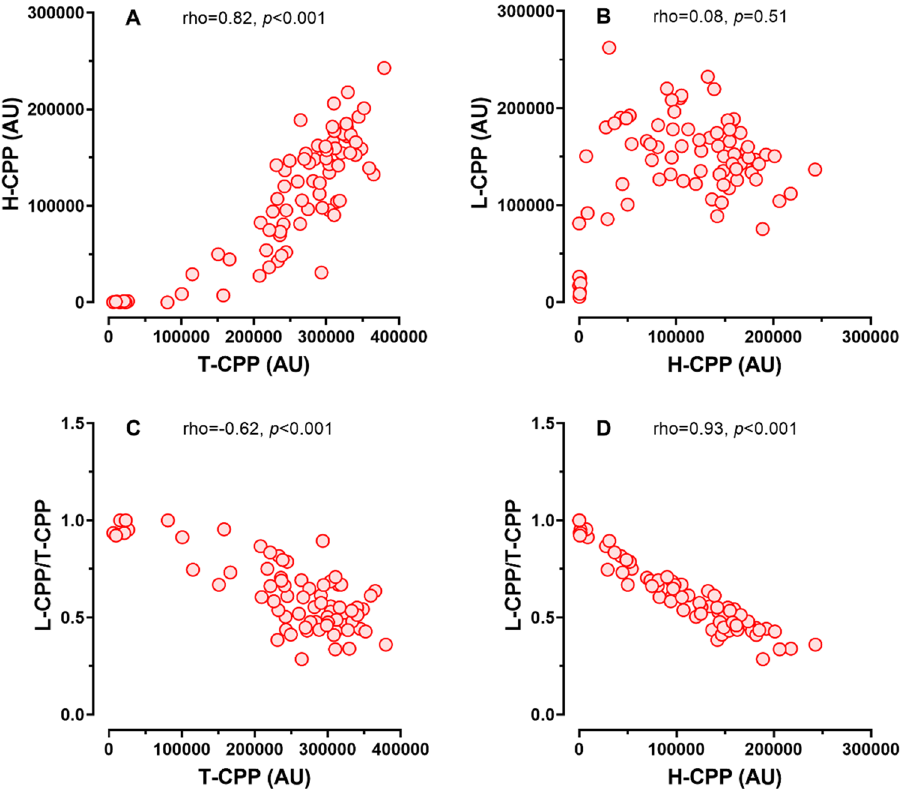
Figure 1. Correlations between H-CPP, T-CPP, L-CPP, and L-CPP/T-CPP among 78 HD patients. Plasma H-CPP levels were positively correlated with T-CPP levels ( A ), but not with L-CPP levels ( B ), the ratio of L-CPP to T-CPP was significantly decreased as the T-CPP ( C ) or H-CPP levels ( D ) were increased. Rho and p values were